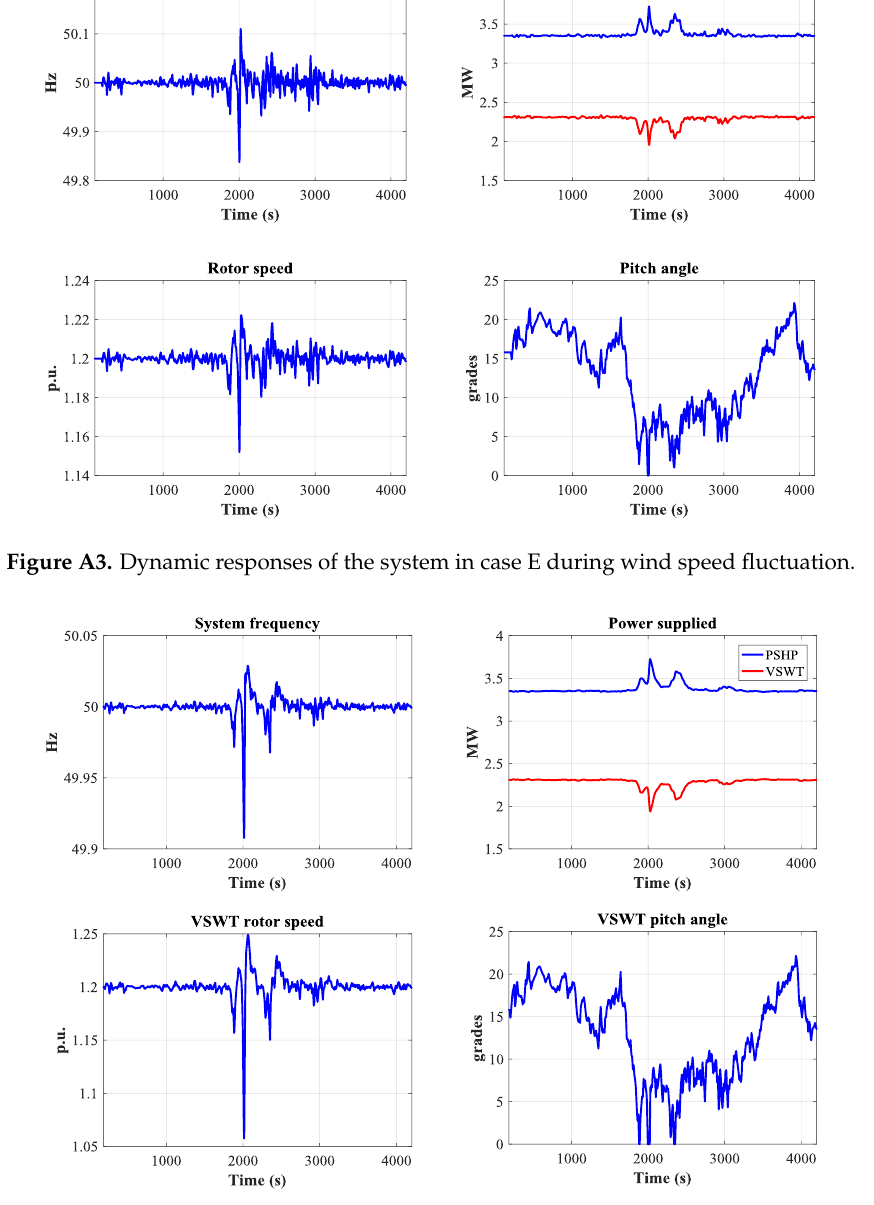
Figure A4. Dynamic responses of the system in case G during wind speed fluctuation.